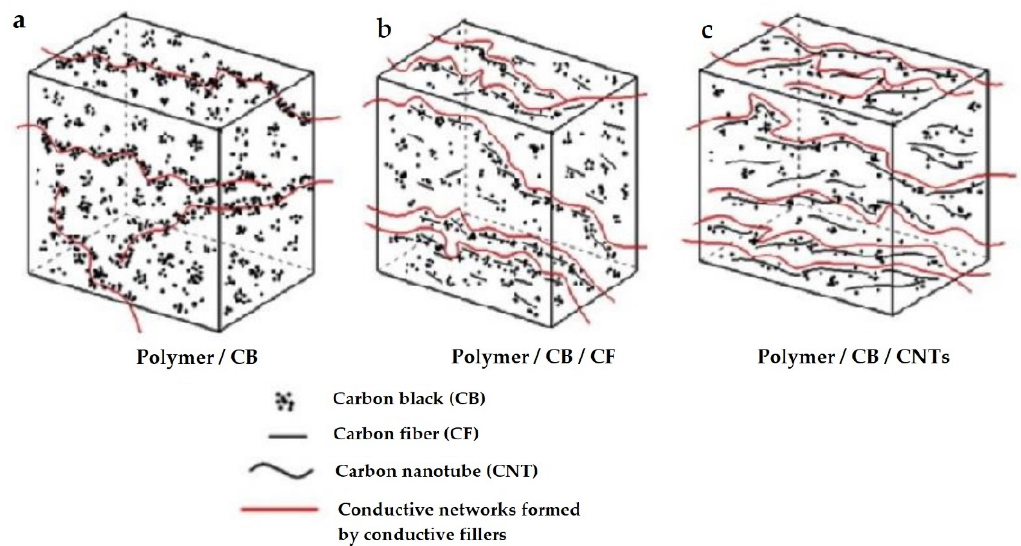
Figure 2. The conductive path formed by Carbon Black ( a ), Carbon black and Carbon fiber ( b ), Carbon Black and Carbon Nanotubes ( c ). Reproduced from [37] with permission from Elsevier 2012.